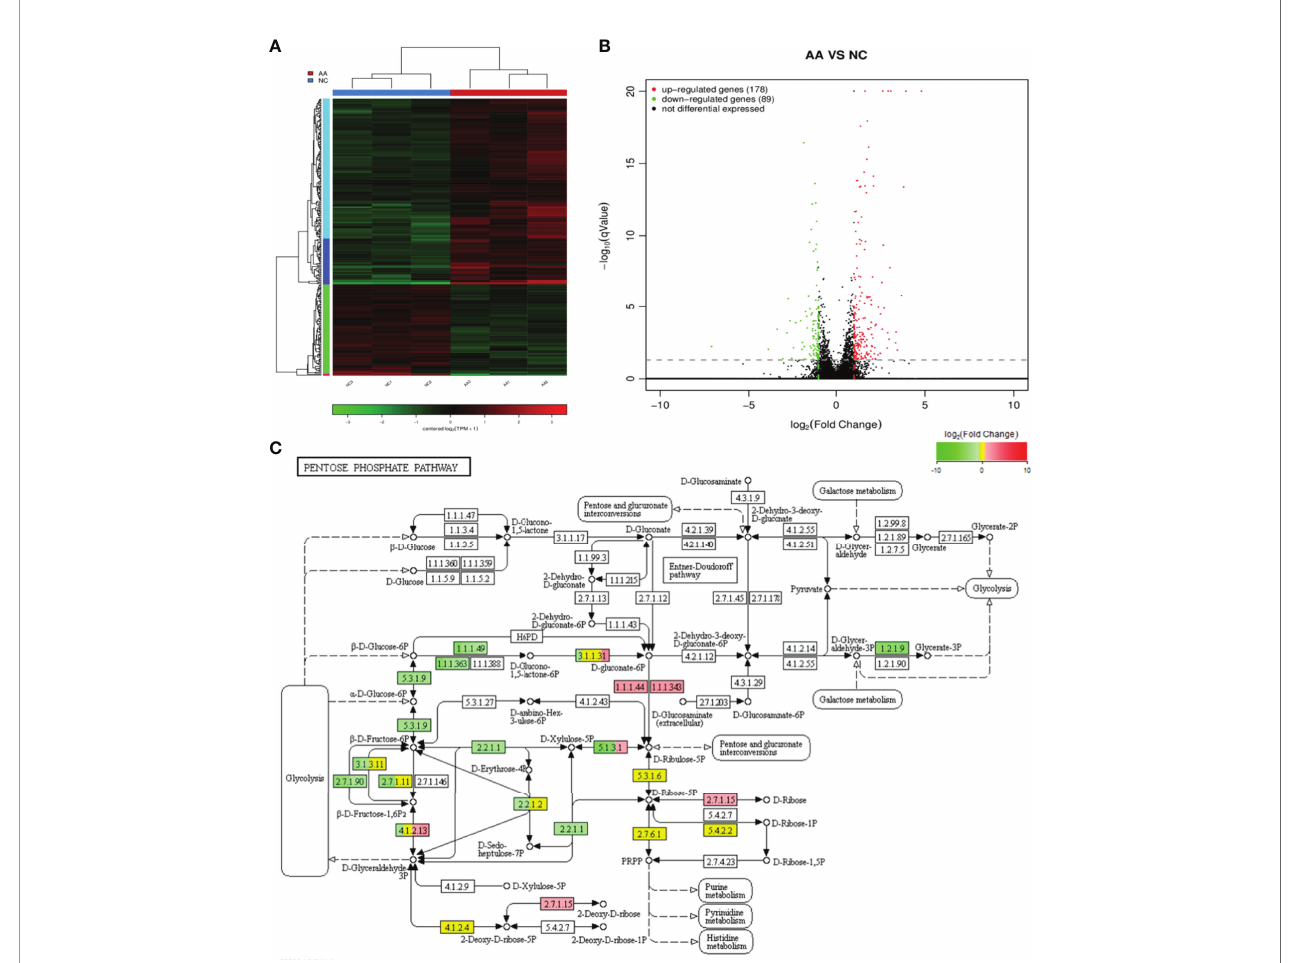
FIGURE 4 | RNA sequencing and bioinformatics analysis (A) Hierarchical clustering heatmaps of differentially expressed genes in the KGN cells after AA treatment (B) Differential gene volcanic map of differentially expressed genes in the KGN cells after AA treatment. (C) Kyoto Encyclopedia of Genes and Genomes (KEGG) pathway classi fi cation of differentially expressed genes. KEGG pathway analysis showed that the differentially expressed genes were involved in different signaling